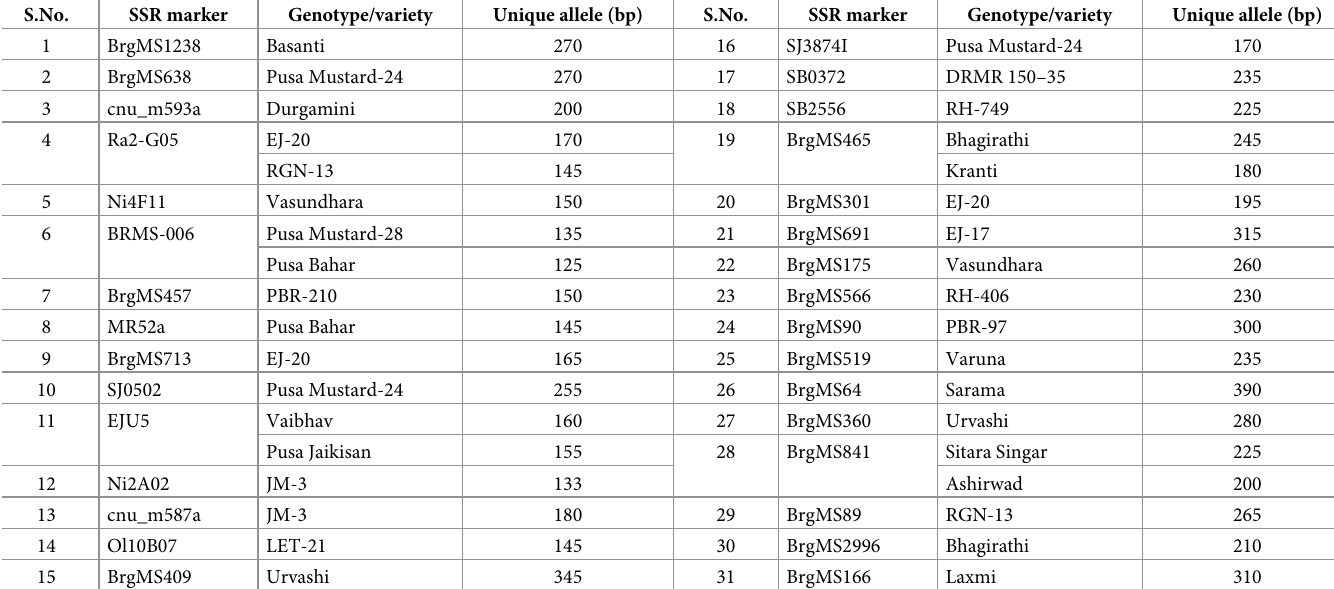
Table 4. Unique alleles/DNA fingerprint for selected Indian mustard